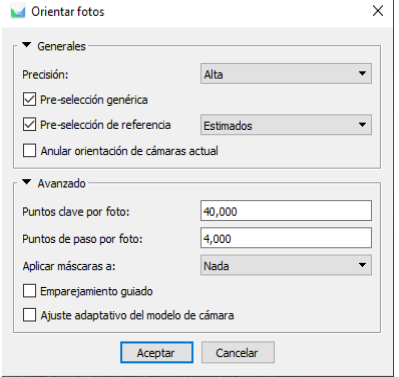
Figure 7. Photo Orientation Parameters of the buildings.